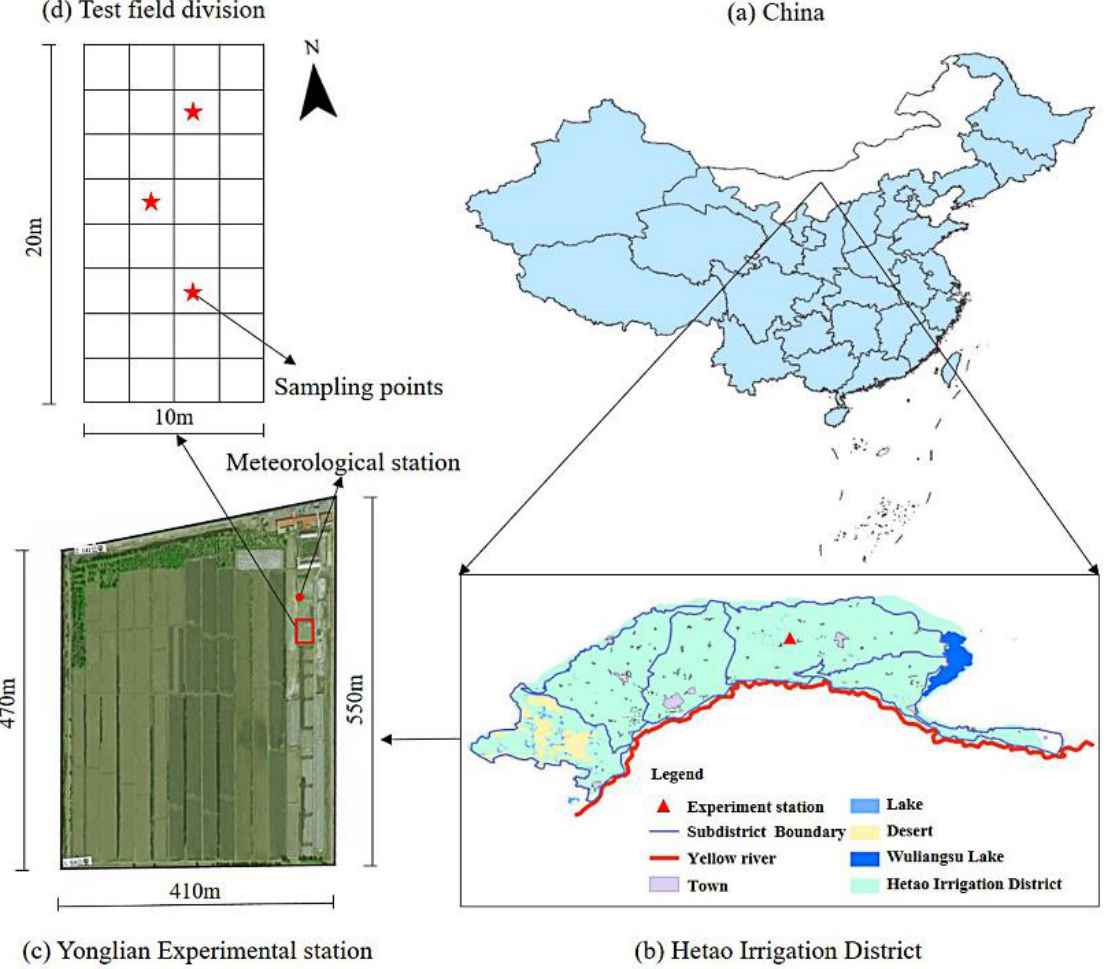
Figure 1. Locations of sampling sites in the study area: ( a ) China; ( b ) Hetao irrigation District; ( c ) Yonglian Experiment station; ( d ) Test field division.